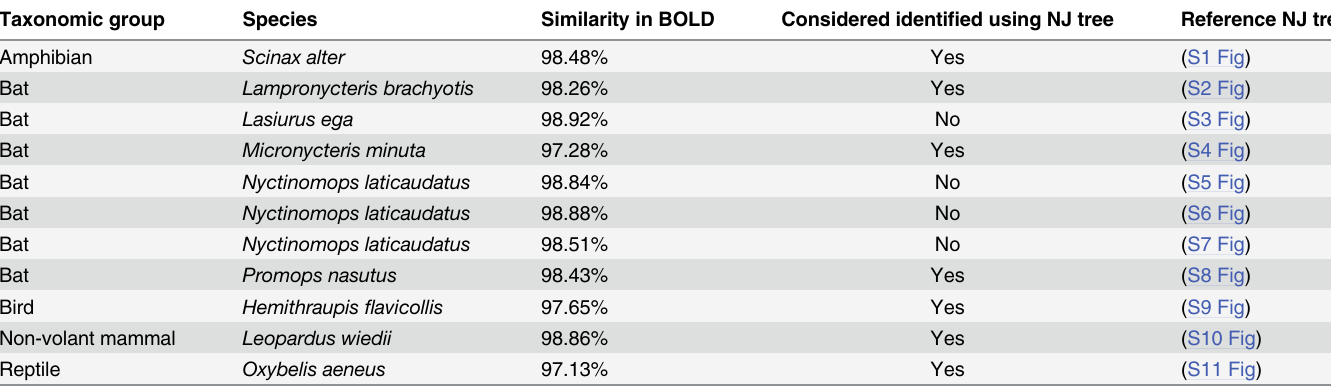
Table 2. Samples with less than 99% similarity after confronting sequences in BOLD. Taxonomic